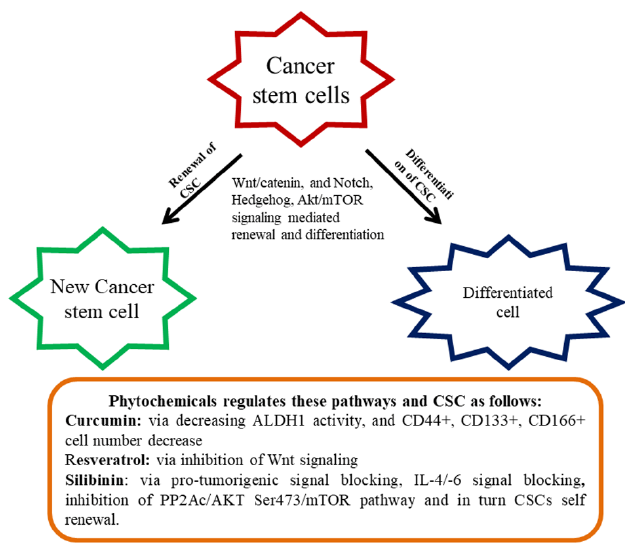
Figure 1. Renewal and differentiation of cancer stem cells (CSC). Diet-derived